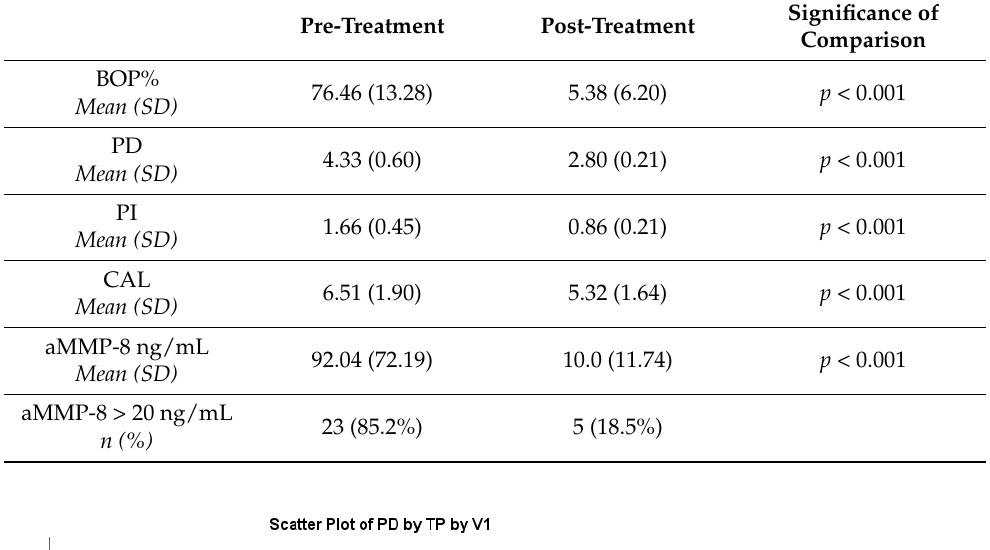
Table 2. Periodontal status and active matrix metalloproteinase-8 (aMMP-8) levels for the study population of 27 periodontitis patients before and after periodontal anti-infective treatment and 25 healthy controls at baseline.